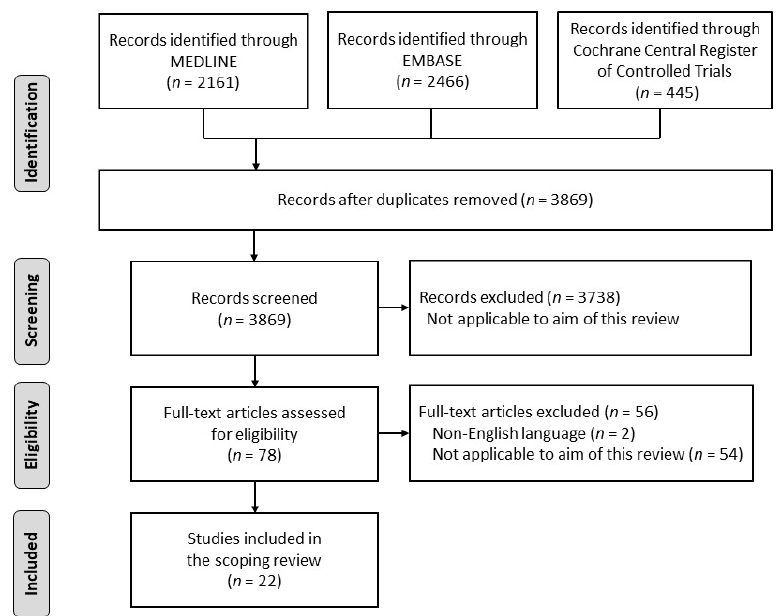
Figure 1. Flowchart of the search strategy. An initial search of studies was performed using the MEDLINE, EMBASE, and Cochrane Central Register of Controlled Trials databases ( n = 5072). Screening for eligibility and full-text assessments were performed. Twenty-two articles were included in the final analysis.